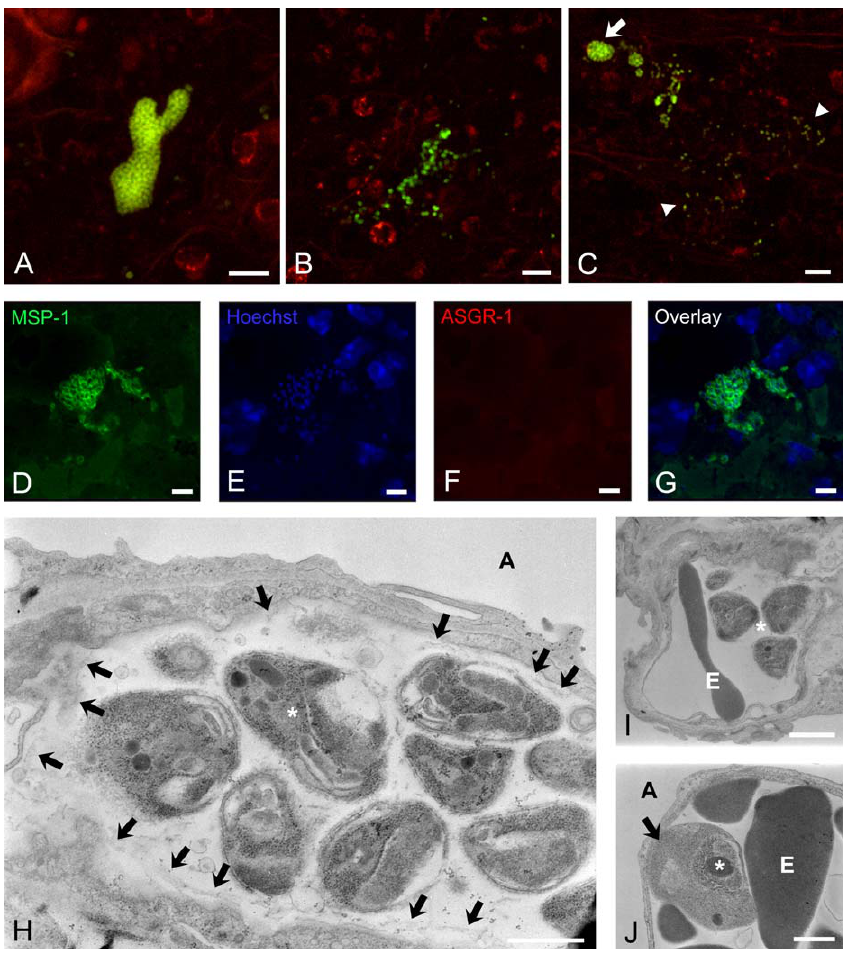
Figure 8. Merosomes Accumulate in the Lungs and Release Merozoites into the Pulmonary Microcirculation (A) Ex vivo confocal microscopy of a mouse lung 52 h after infection with PyGFP shows a large merosome located inside an alveolar capillary. (B) A group of individual merozoites inside pulmonary capillaries. (C) Small parasite aggregates and individual merozoites (arrowheads) fanning out in one direction from a merosome (arrow). This asymmetric parasite distribution suggests that merosomes release merozoites into the pulmonary microcirculation. (A–C) Bars ¼ 10 l m. (D–G) Mouse lung fixed 52 h after infection with P. yoelii . The frozen section was immunolabeled with MSP-1 followed by protein A-FITC (D, green) indicating that the merozoites are intact. Labeling with goat-anti-ASGR-1 followed by rabbit anti-goat IgG-TX (E, red) revealed the absence of the receptor on the merosomal membrane. Nuclei were visualized by Hoechst staining (F, blue). (H) Electron micrograph showing well-preserved merozoites ( (cid:2) ) in the lumen of an alveolar capillary. Only fragments of the merosomal membrane are detectable (arrows). *, merozoite; A, alveolar lumen. Bar ¼ 1 l m. (I) Free merozoites released into the lumen of a pulmonary capillary. *, merozoite; E, erythrocyte. Bar ¼ 1 l m. (J) Alveolar capillary showing an erythrocyte (arrow) harboring a recently invaded merozoite in addition to several uninfected erythrocytes. *, merozoite; E, erythrocyte. Bar ¼ 1 l